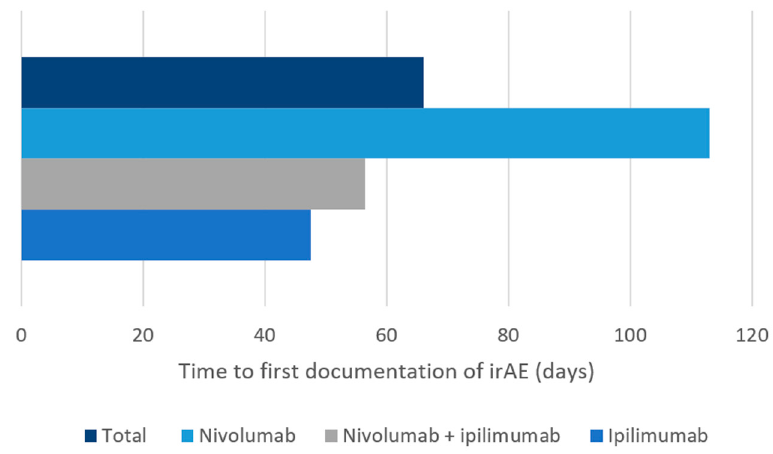
Figure 2. Median time to first immune-related adverse event documentation from the first dose of nivolumab, ipilimumab, or nivolumab plus ipilimumab, in medical oncology patients at Nova Scotia Health-Central Zone. irAE: immune-related adverse event. Table 4. The proportion of medical oncology patients in the Nova Scotia Health-Central Zone treated with nivolumab, ipilimumab, or nivolumab plus ipilimumab who discontinued treatment or died between